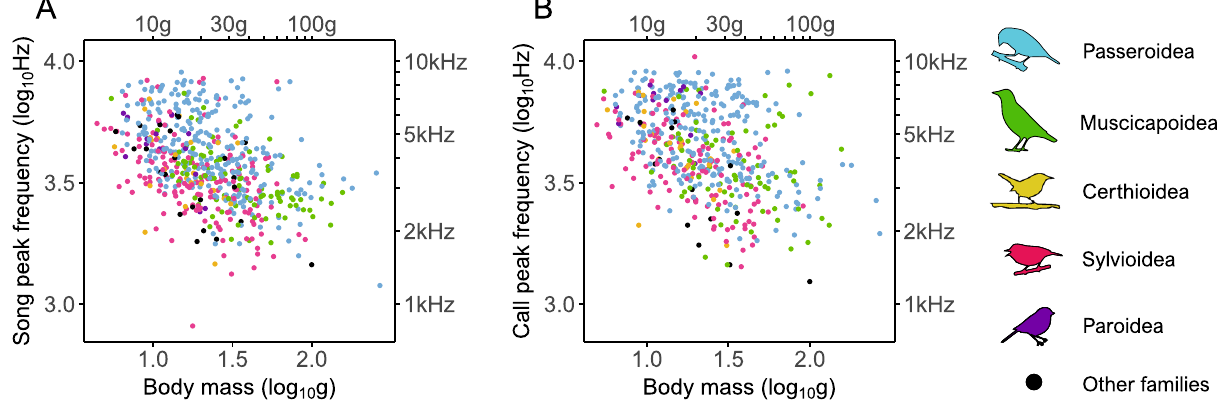
Figure 2. Relation of peak frequency and body mass across species. ( A , B ) Scatterplots of peak frequency and body mass for ( A ) songs or ( B ) calls. Species are colored by